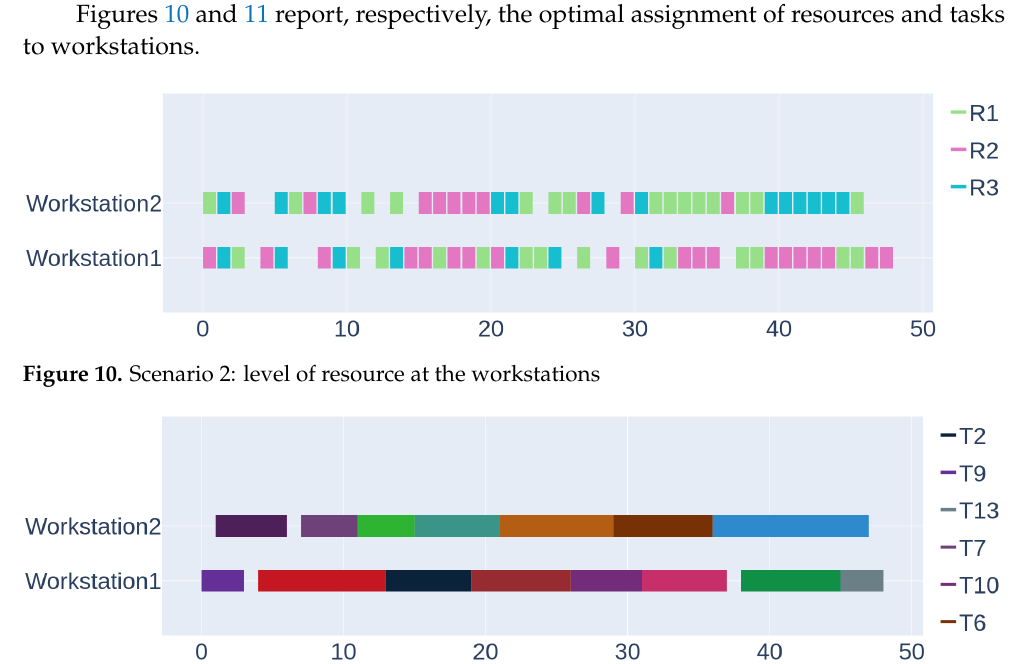
Figure 9. Scenario 2: Observed make-span at each training episode.